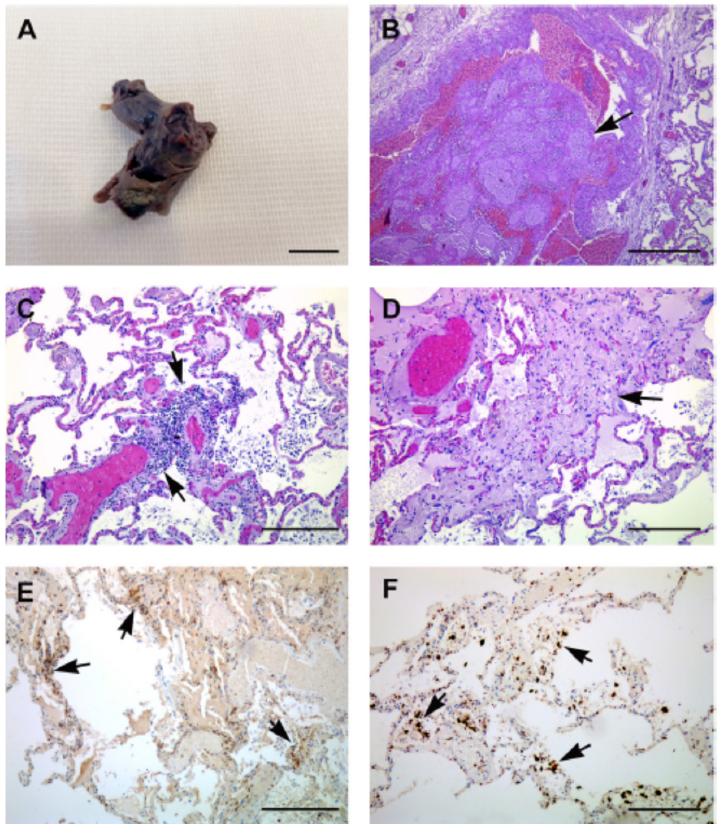
piece of hemorrhagic tissue that is reddish-tan and measures approximately 1.3 cm in diameter. ( B ) An intravascular thrombus of a major vessel can be seen in the light microscopy image of the lung tissue segment (arrow). ( C ) Inflammatory cells can be seen in the pulmonary interstitium (shown by the arrows) and in the alveolar space of the lung parenchyma. ( D ) There is evidence of widespread interstitial fibrosis in the lungs (arrow). Diffusely prevalent in the alveolar septa and around the arteries are a substantial number of CD4+ T cells ( E ) and CD68+ macrophages ( F ) (arrows). Bars on the scale read as follows: ( A ) = 1 cm; ( B ) = 100 m; ( C – F ) = 50 m